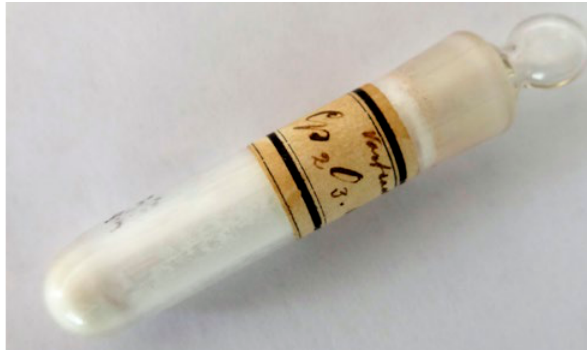
Figure 11. Test tube with a lutetium preparation (Cp 2 O 3 ) originally produced by Carl Auer von